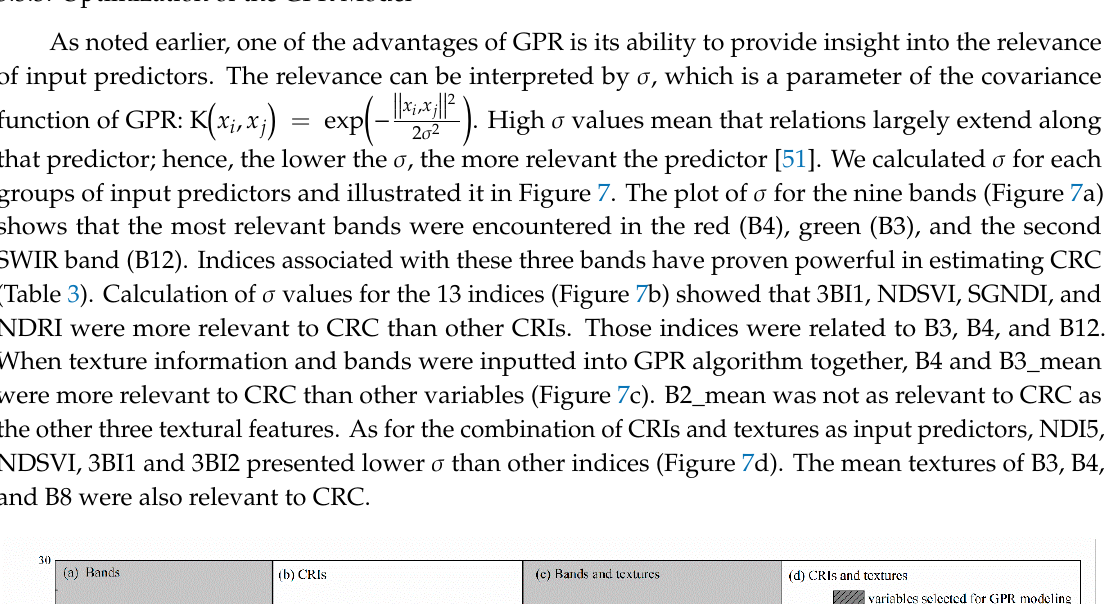
Table 6. Performance of the optimized GPR models. The best-performing input variable combination for GPR is highlighted in boldface. Algorithm